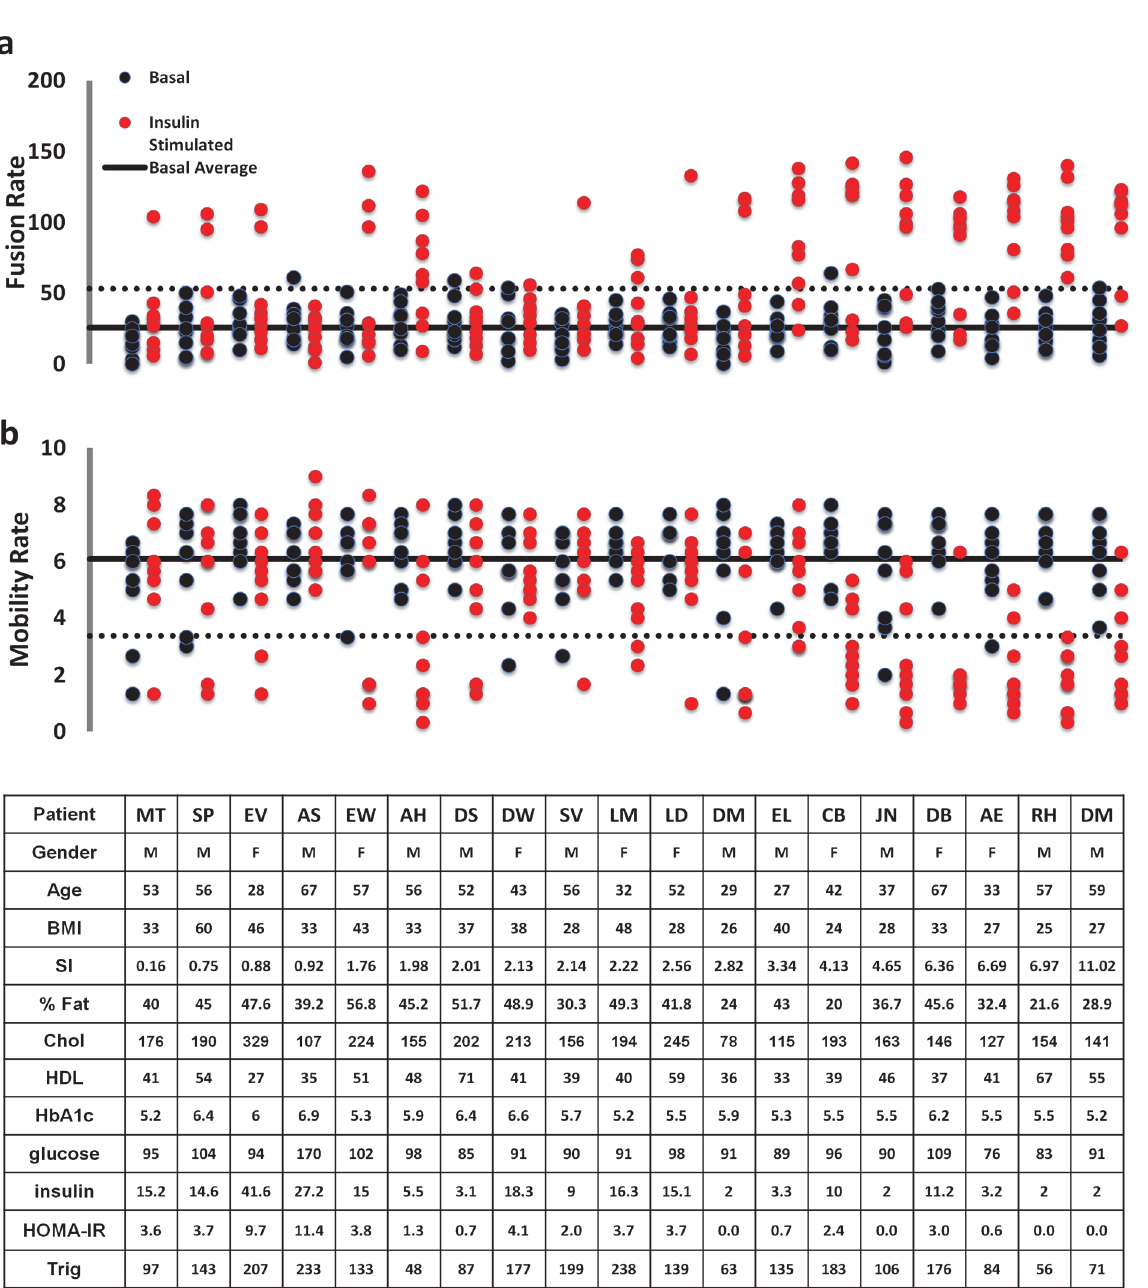
Fig 1. Dot plot of basal and insulin-treated cellular activities, GLUT4 storage vesicle (GSV) fusion and mobility rates, in adipose cells isolated from subjects with varying degrees of insulin sensitivity. For each subject (N = 19), eight cells were evaluated in the basal (black) and insulin-stimulated states (red). Subject ID, gender, age, BMI, SI and %Fat is shown below each group of cell measurements. Both GSV mobility and fusion rates were acquired from time-lapse TIRF recordings of isolated adipose cells transfected with GLUT4-mCherry and IRAP-pHlourin The upper panel (a) shows fusion rates measured in individual cells isolated from each subject. GSV fusion events were detected as spikes of IRAP-pHluorin fluorescence representing expansion of the fusion pore and pH equilibration within the lumen of the fusing GSV. Fusion rate for each cell was calculated as the number of IRAP-pHluorin spikes detected per unit area during one minute of recording. The lower panel (b) shows GSV mobility rates measured as the number of mobile GLUT4-mCherry vesicles detected in the TIRF-zone (within * 200 μ m of the cell membrane). GSV mobility rate was measured in isolated basal or insulin-treated cells and quantified as the number of mobile vesicles (with trajectory length > 2 μ m) detected within a 10x10 μ m region of interest during one minute of recording (60 frames). The solid black lines represent average basal rates calculated from the pooled population of basal cells for each subject. The dotted lines represent 95% confidence intervals for pooled basal values. With increasing SI (from left to right), an increasing number of insulin-stimulated cells exhibit GSV mobility and fusion rates outside the 95% confidence interval calculated from the basal values.